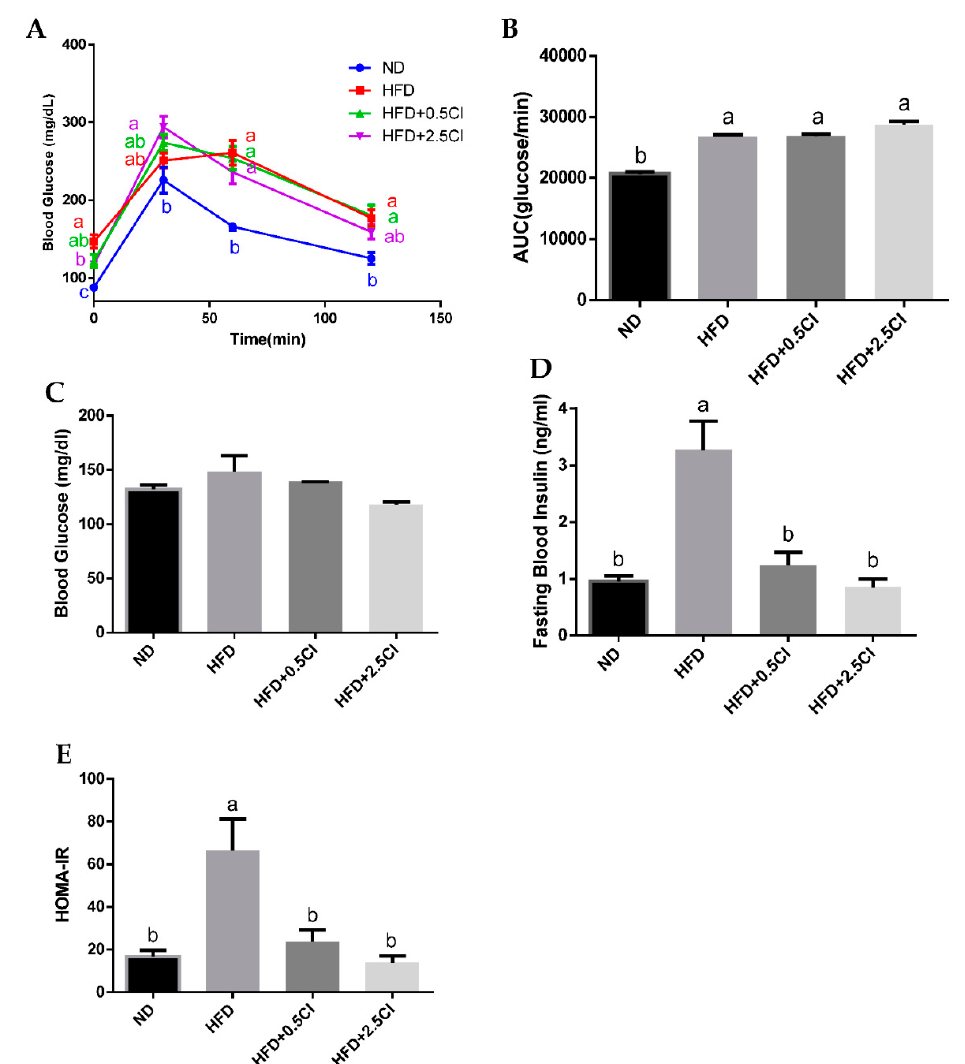
Figure 3. Effects of Chiliadenus iphionoides supplementation on glucose homeostasis. Male C57BL/6J mice were fed with normal diet (ND), high-fat diet (HFD), high-fat diet + 0.5 mg/kg Chiliadenus iphionoides (HFD + 0.5CI), high-fat diet + 2.5 mg/kg Chiliadenus iphionoides (HFD + 2.5CI) for fifteen weeks. ( A ) An oral glucose tolerance test for 120 min was performed at week 14; ( B ) Glucose tolerance test measured as the area under the curve (AUC); ( C ) Mean fasting blood glucose concentration at sacrifice; ( D ) Insulin serum levels at sacrifice; ( E ) Homeostatic model assessment of insulin resistance index (HOMA-IR). Values are expressed as mean ± SEM (ND = 9, HFD groups n = 10). Different letters denote significant difference ( p < 0.05, Tukey’s HSD).